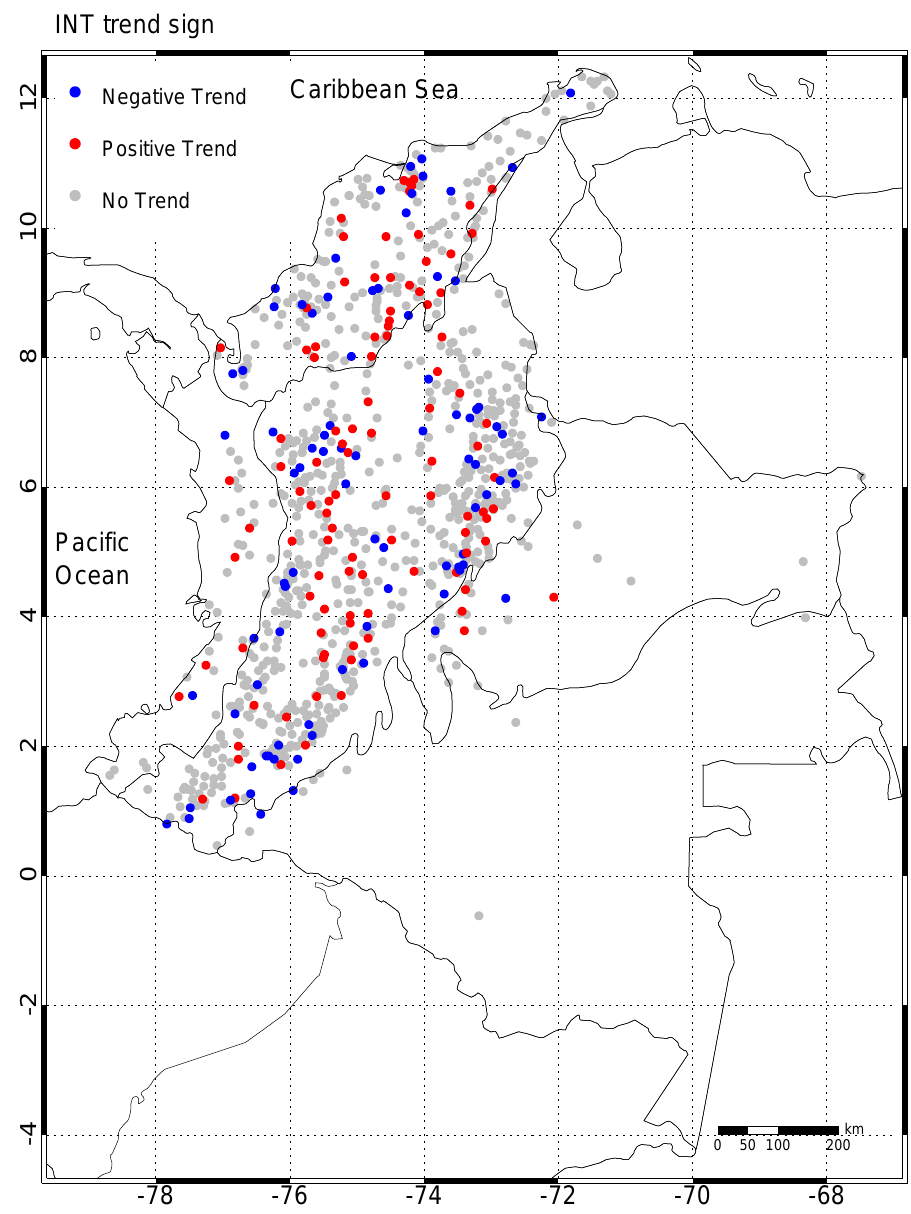
Figure 4. Map of the trend sign for INT for rain gauge base dataset. Non-significant trends are plotted in